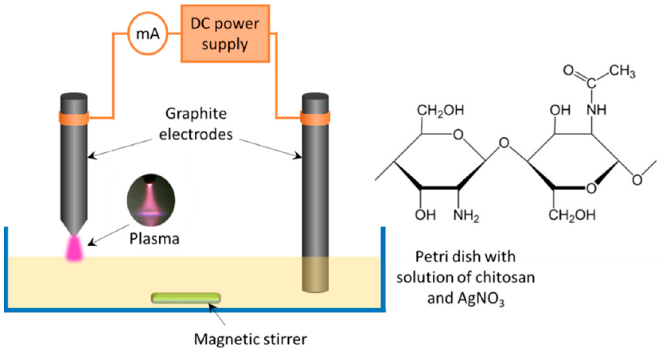
Figure 1. Scheme of the experimental setup and chitosan chemical structure.